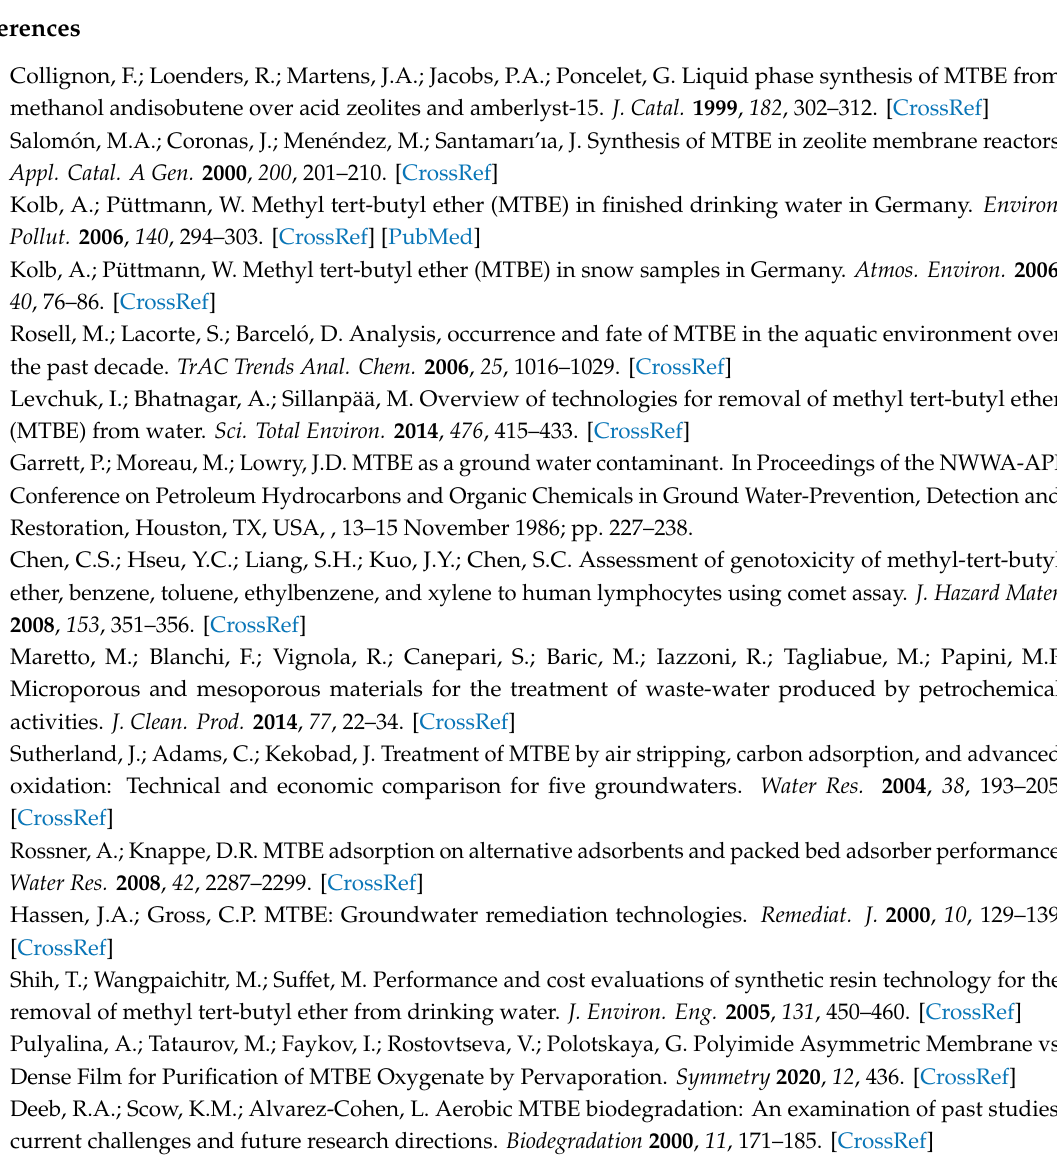
Figure S1: DSC curves of